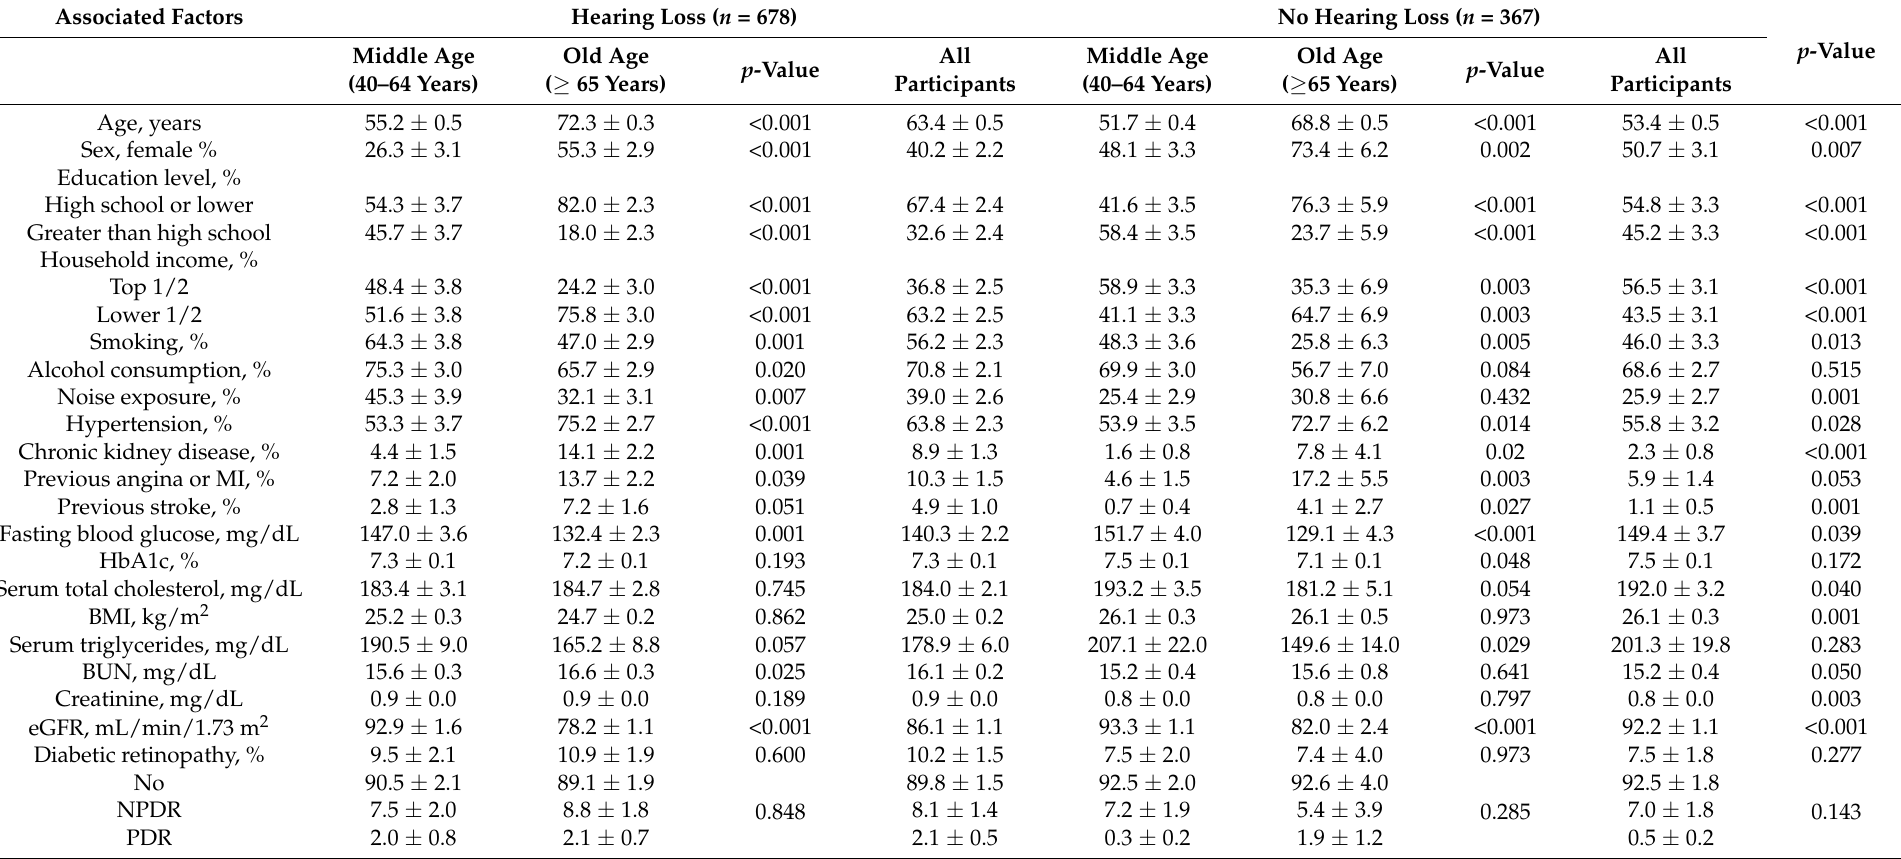
Table 2. Comparison of demographic data between participants with and without hearing